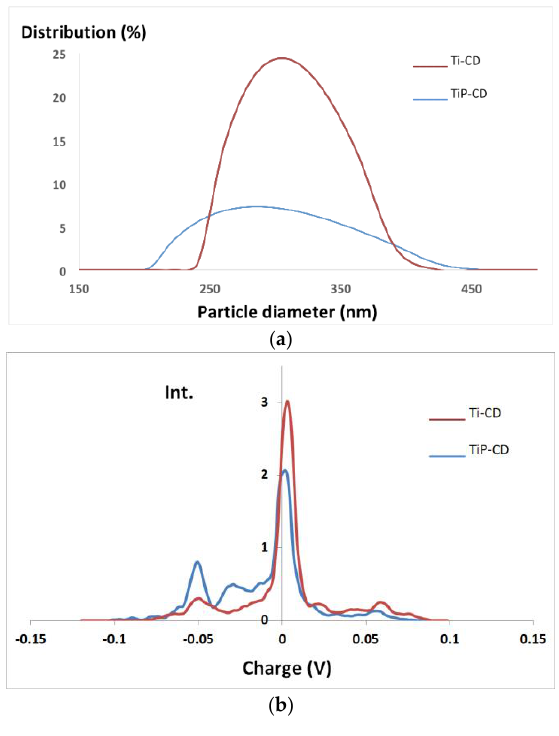
Figure 4. ( a ) DLS spectra and ( b ) Zeta potential of Ti-CD and TiP-CD.